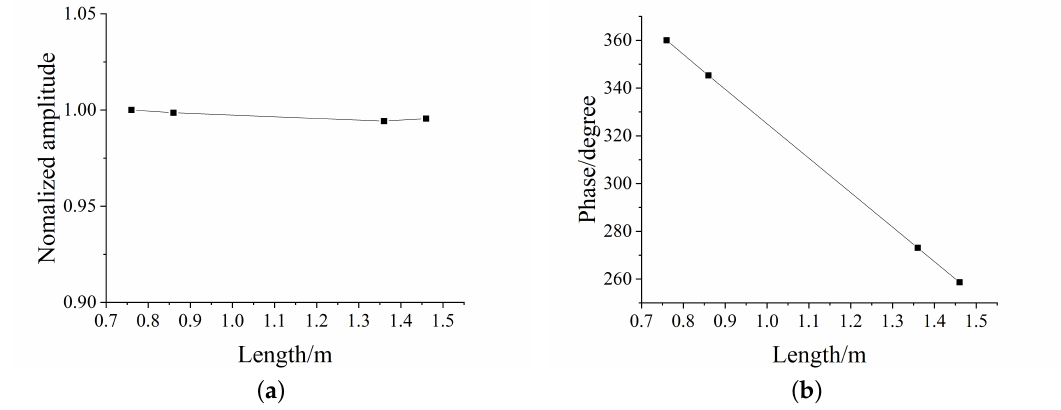
Figure 16. ( a ) The relationship between acoustic pressure amplitude and impedance tube length with steel sample at 600 Hz. ( b ) The relationship between acoustic phase and impedance tube length with steel sample at 600 Hz.